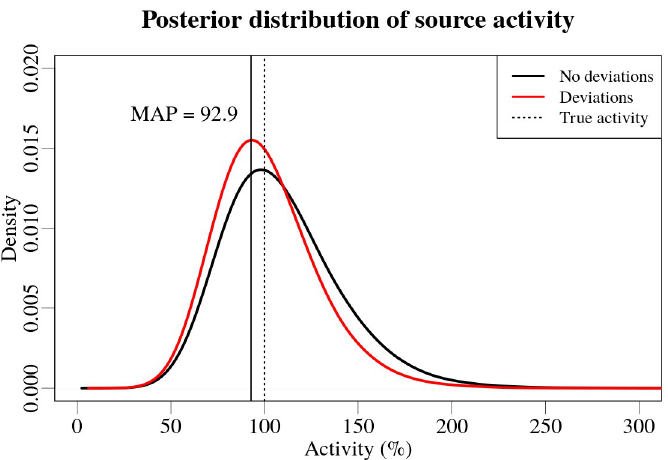
Fig 12. Posterior distributions for activity of the source for simulated data without (black) and with (red) the synthetic deviations in the measurement coordinates. The vertical dashed line marks the true activity of the source. The activity values are expressed in terms of percent of the activity of the source (100